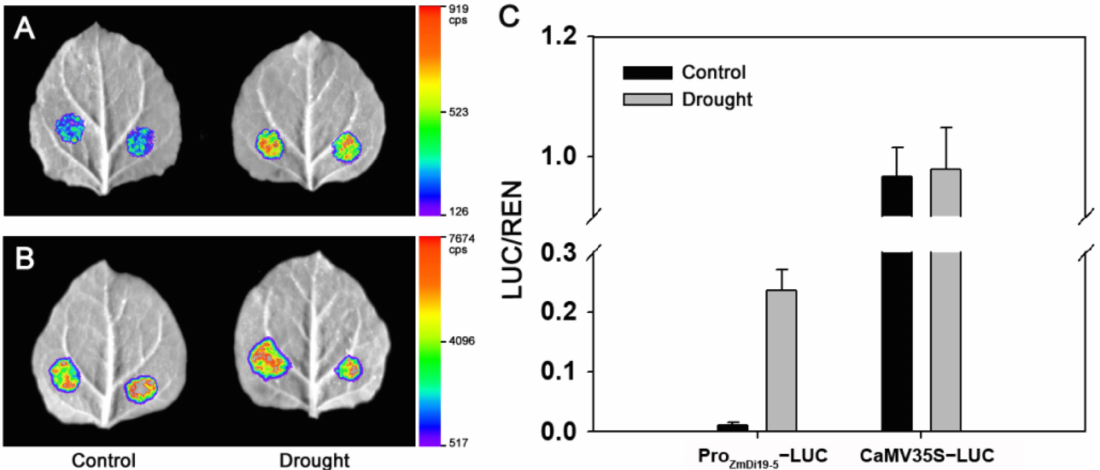
Figure 6. LUC expressed activity of ZmDi19-5 promoter under control and drought conditions. ( A ) LUC expressed activity driven by ZmDi19-5 promoter; ( B ) LUC expressed activity driven by 35S promoter; ( C ) Quantitative analysis of LUC activity under control and drought conditions.